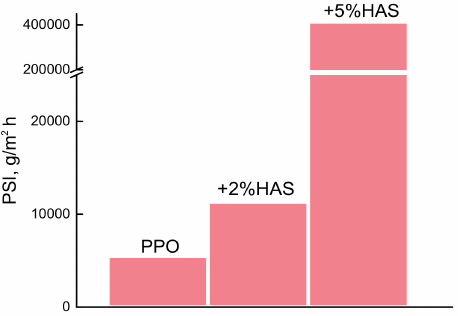
Figure 7. Pervaporation separation index of PPO-based membranes in pervaporation of EG / water mixture containing 5 wt% water, 50 ◦